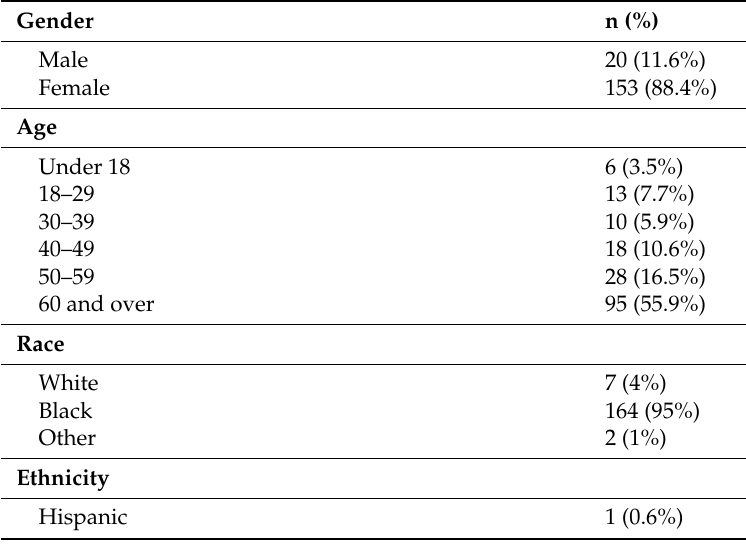
Table 1. Participant Demographics (n =